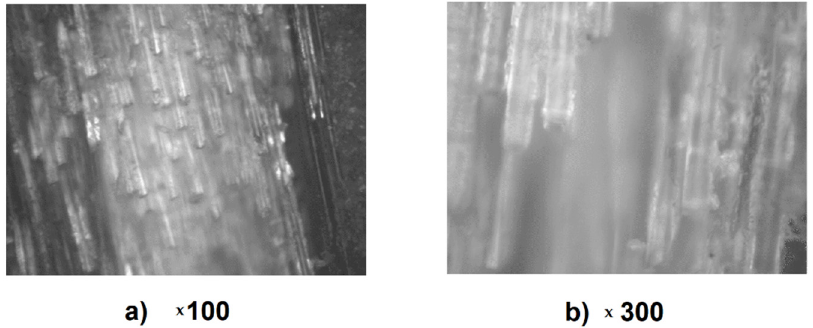
Figure 5. Stuffed material specimens with cure times of 10 min at zoom of ( a ) × 100 and ( b ) × 300.